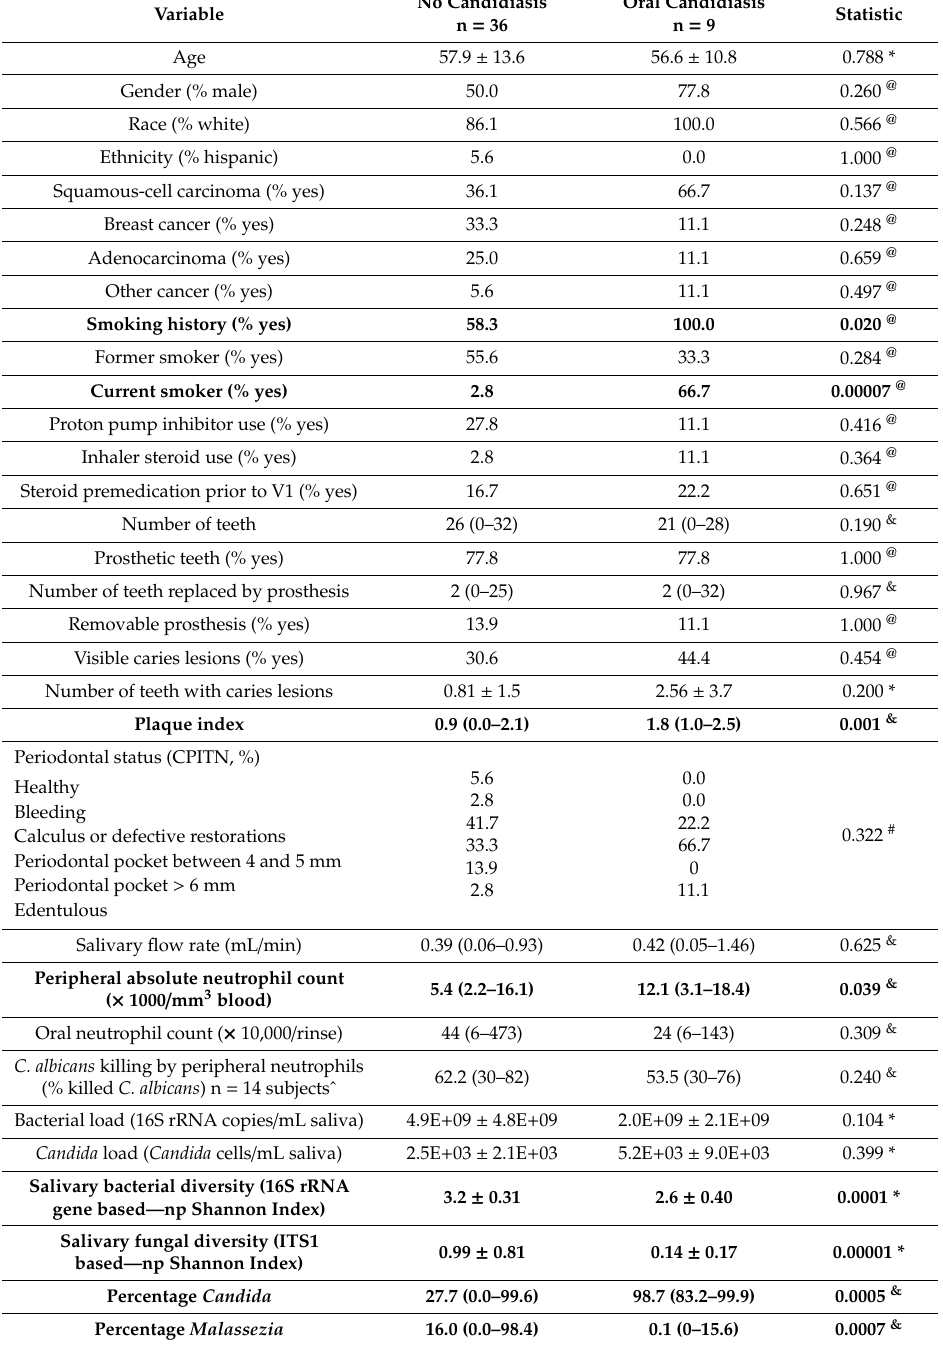
Table 1. Baseline characteristics of the study subjects according to the oral candidiasis diagnosis during the chemotherapy cycle. All data represent information collected or measurements taken at baseline, prior to the chemotherapy